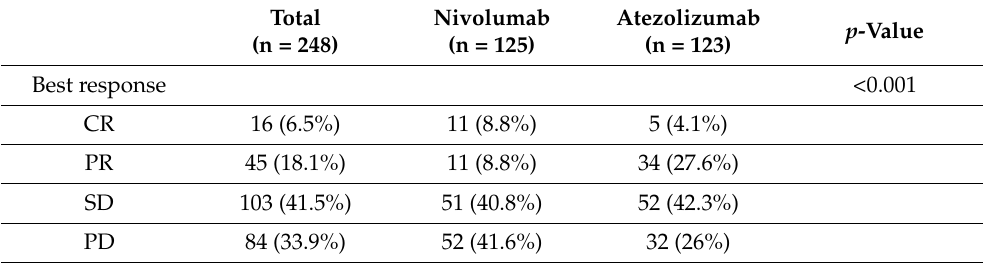
Table 2. Response to previous chemotherapy.